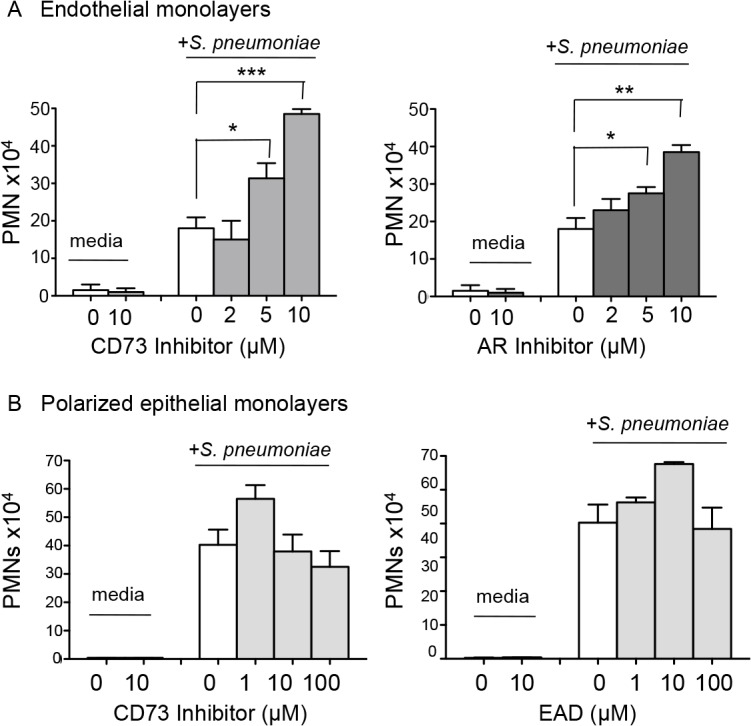
EAD negatively regulates PMN migration across the endothelium but not the epithelium.(A) Media alone or S. pneumoniae-containing media was added to the lower chamber of HUVEC-seeded Transwell dishes for 3 hours. Transmigration of PMNs added to the upper chamber in media containing vehicle control or increasing concentrations of the CD73 inhibitor α,β- methylene ADP (left panel) or pan-adenosine receptor (AR) inhibitor CGS 15943 (right panel) was measured using a hemocytometer. The means +/- SEM from one representative of three experiments are shown and values significantly different from media control, determined by student’s t-test, are indicated by asterisk (*** = p< 0.0001; ** = p< 0.001; * = p<0.05). (B) Polarized H292 epithelial cells, pre-treated with increasing concentrations CD73 inhibitor α,β- methylene ADP (left panel) or just adenosine (right panel), were left uninfected (“media”) or infected apically with pneumococcus (“+ S. pneumoniae”). The transmigration of PMNs, added to the basolateral side in media alone or the indicated concentrations of CD73 inhibitor or adenosine was measured by myeloperoxidase ELISA. Data represent means +/- SEM, and shown are one of three separate experiments.